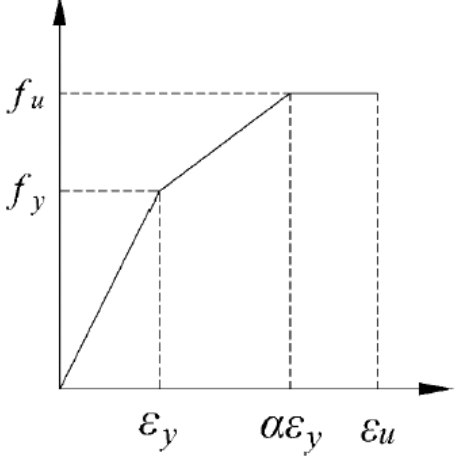
Figure 5. Constitutive model of the steel plate.